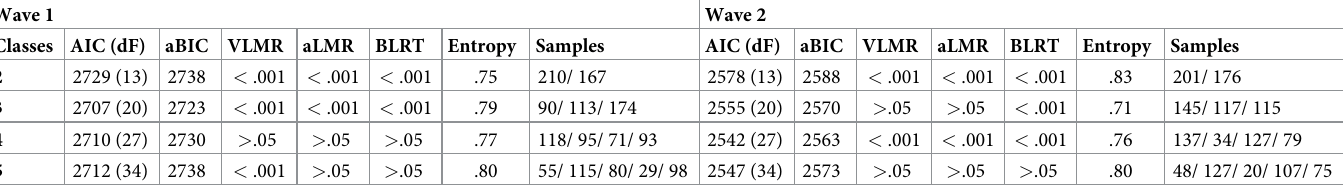
Table 3. Latent class analysis model fit statistics to select the number of classes of well-being at school for both waves sequentially. Wave 1